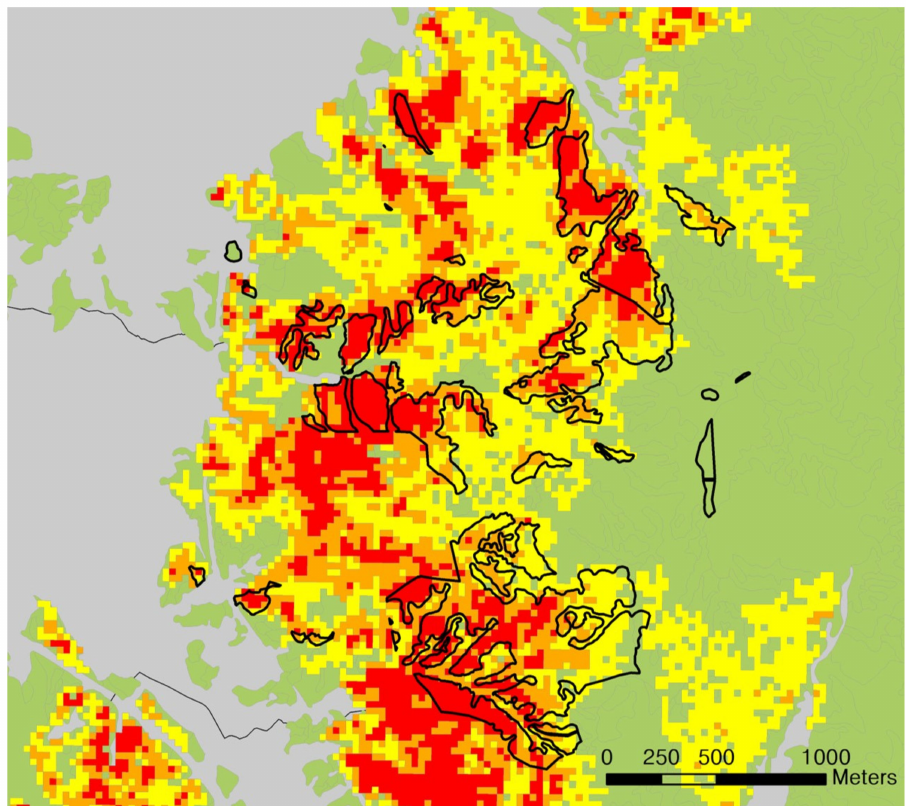
Figure 1. Comparison between field survey results and Landsat-based gypsy moth defoliation maps in the center of Wonju. Damage degree represents the mean reduction in Normalized Difference Moisture Index (NDMI) scores calculated using all the available observations in June from 2017 to 2019. The closed curves indicated the larch stands defoliated by gypsy moth observed through a field